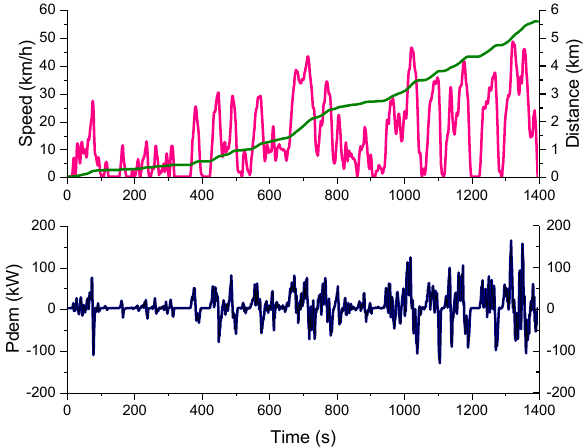
Figure 10. Harbin city driving cycle and the power demand.